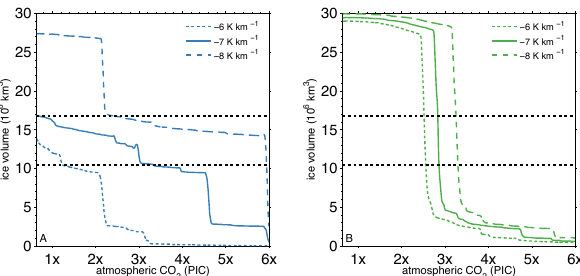
Fig. 5. Transient CO 2 experiments with varying values for the lapse rate parameter. (a) Using climate output from CCSM3_H simula- tions. (b) Using climate output from GENESIS simulations. The horizontal dashed lines are the ice volumes for an intermediate and large ice sheet. Note the high sensitivity to the lapse rate parameter of the CCSM3_H simulations.